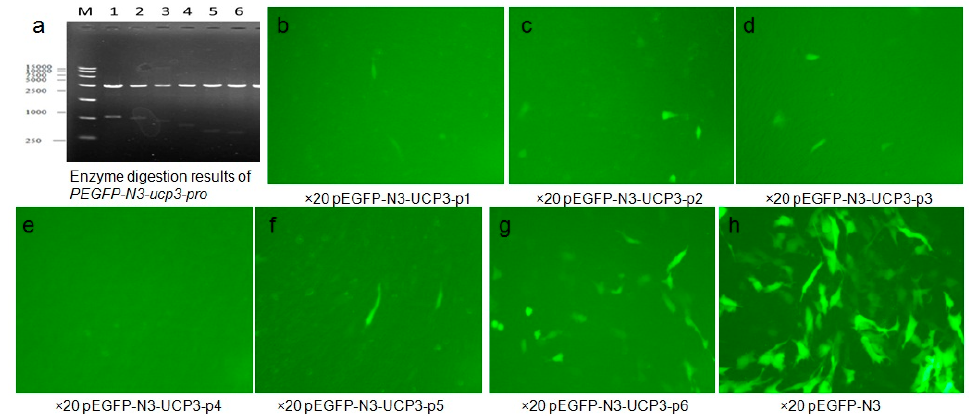
Figure 6. Identification and analysis of PEGFP-N3-ucp3-pro. ( a ) Enzyme digestion results of PEGFP-N3-ucp3-pro recombinant plasmid. M represent 15,000 bp marker, from1 to 6, the results represent PEGFP-N3-ucp3-p1–PEGFP-N3-ucp3-p6, respectively; ( b – h ) The green fluorescence of recombinant expression vector PEGFP-N3-ucp3-pro transitional C2C12 cell (Fluorescent inverted microscope ×20).